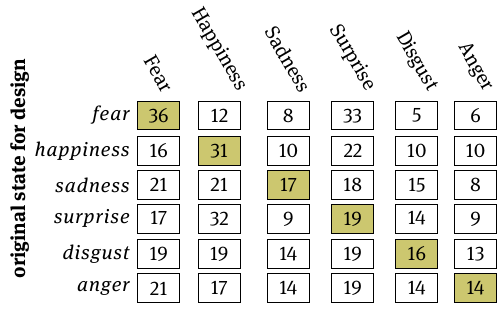
Figure 7: Confusion matrix representing for each expressive se- quence (fear, happiness, sadness, surprise, disgust, anger) the % of participants having considered a given emotional state as the best candidate to qualify for this sequence. For instance, 33% of participants considered Surprise as the best candidate for the se- quence designed to convey the emotion of